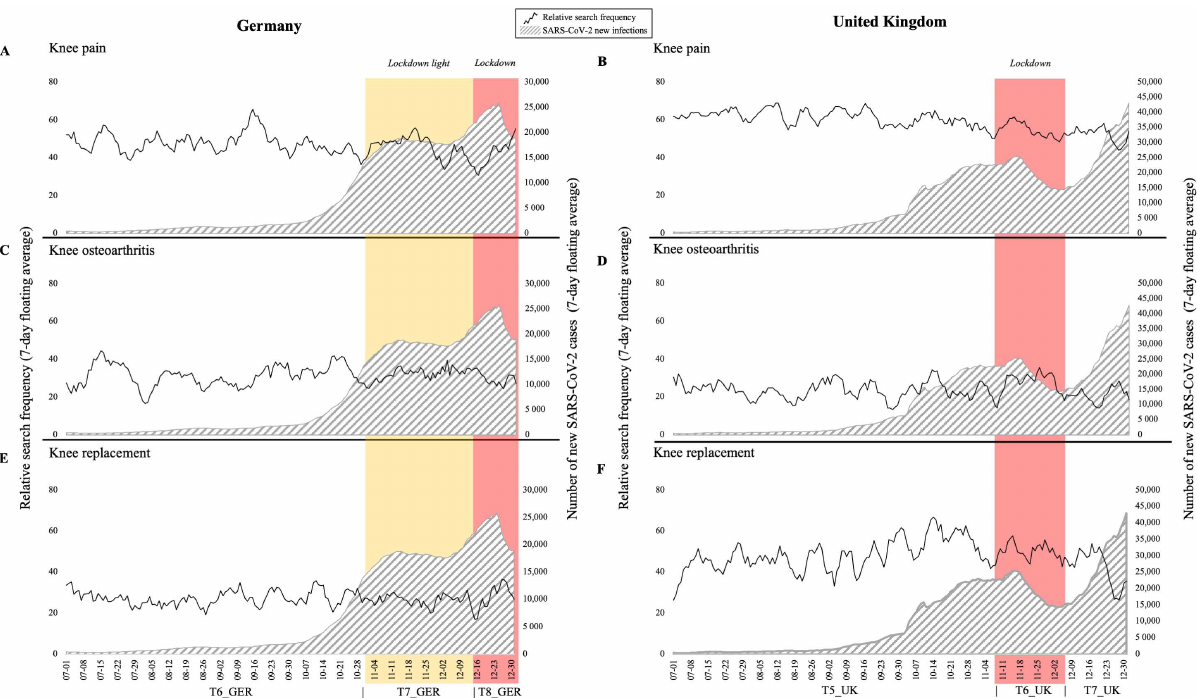
Figure 1. Public interest as relative search frequencies (black curve) of ( A , B ) knee pain, ( C , D ) knee osteoarthritis, and ( E , F ) knee prosthesis and number of new SARS-CoV-2 infections (grey, striped area) in the first half of 2020 in Germany and the UK, respectively. Relevant events and time frames are highlighted in color.